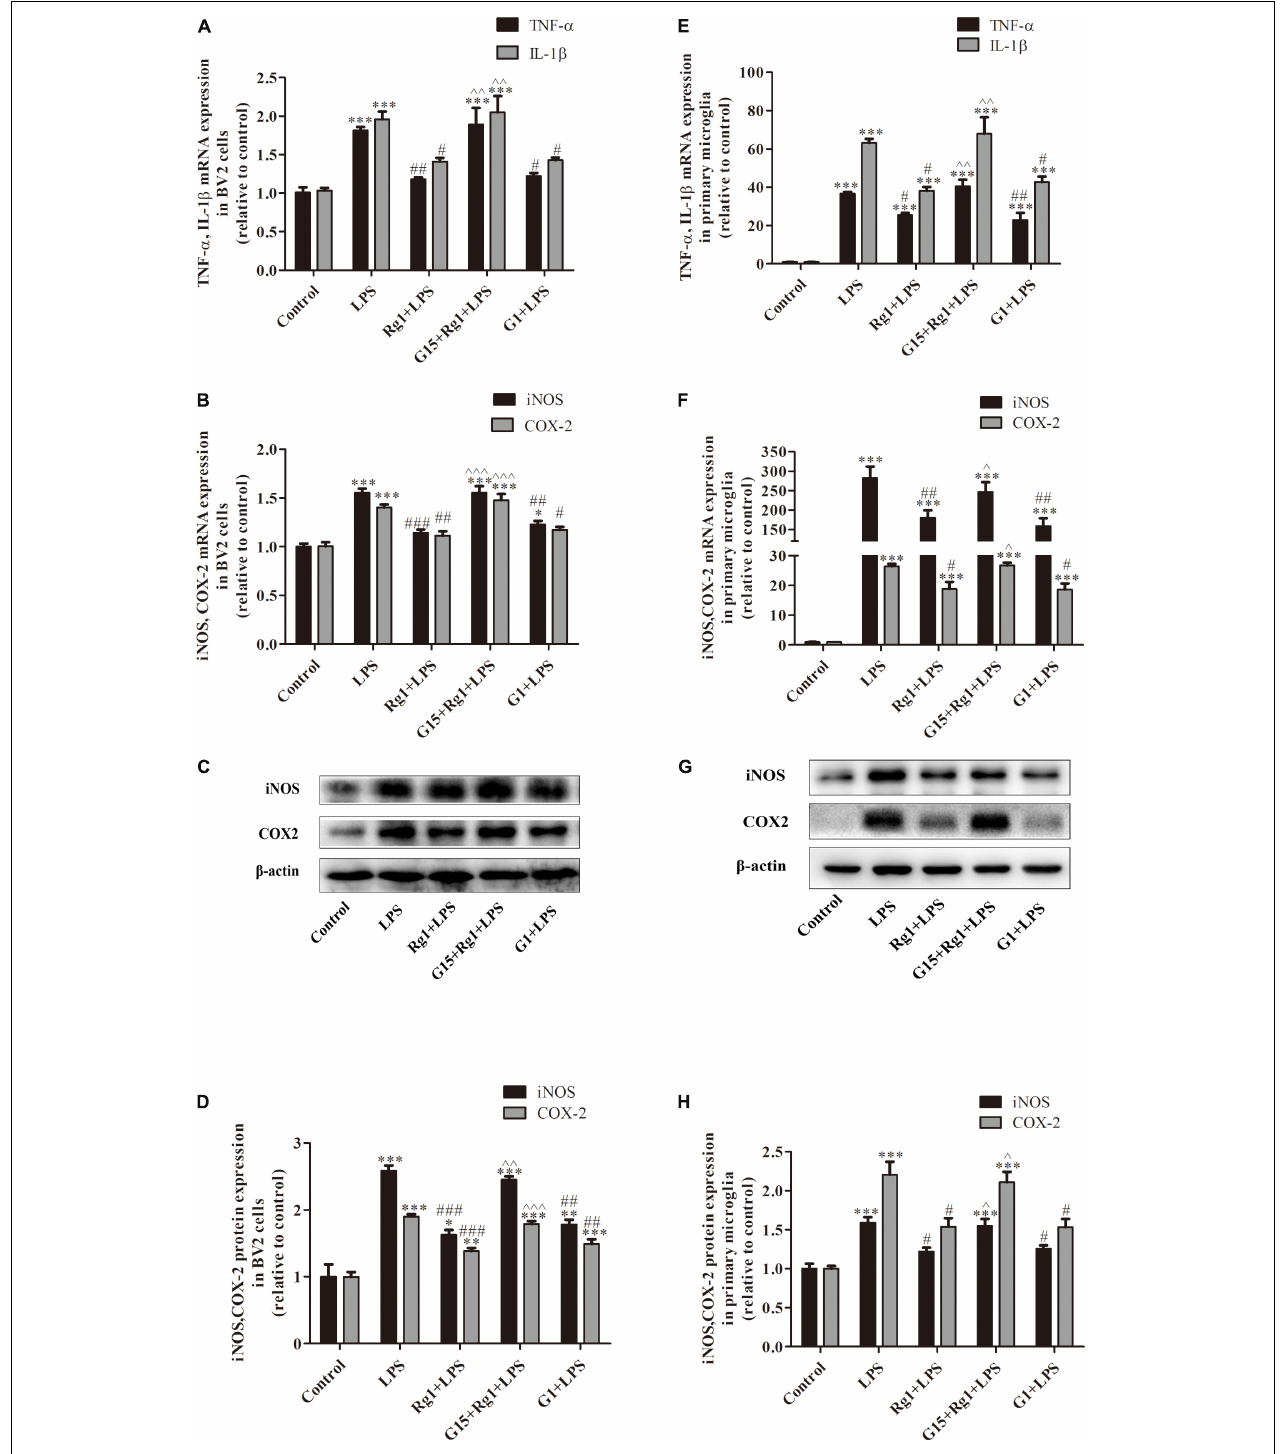
FIGURE 3 | The GPER was involved in the inhibitory effects of Rg1 on mRNA and protein expression of proinflammatory cytokines in BV2 cells and primary microglia. BV2 cells (A–D) and primary microglial cells (E–H) were pretreated with 1 µ M G15 for 1 h, followed by 10 µ M Rg1 or 1 µ M G1 for 1 h. LPS (BV2 cells: 1 µ g ml − 1 ; primary microglia: 0.5 µ g ml − 1 ) was used to stimulate the cells for 6 h to collect the total RNA or for 24 h to detect protein expression. TNF- α , IL-1 β , iNOS, and COX-2 mRNA levels were measured using real-time PCR. GAPDH was used as an internal control. Western blot was used to detect iNOS and COX-2 protein levels. β -Actin was used as an internal control. Results are expressed as the mean ± SEM, n = 3–5. ∗ P < 0.05, ∗∗ P < 0.01, and ∗∗∗ P < 0.001 versus control; # P < 0.05, ## P < 0.01, and ### P < 0.001 versus the LPS group; ∧ P < 0.05, ∧∧ P < 0.01, and ∧∧∧ P < 0.001 versus the Rg1 + LPS group.